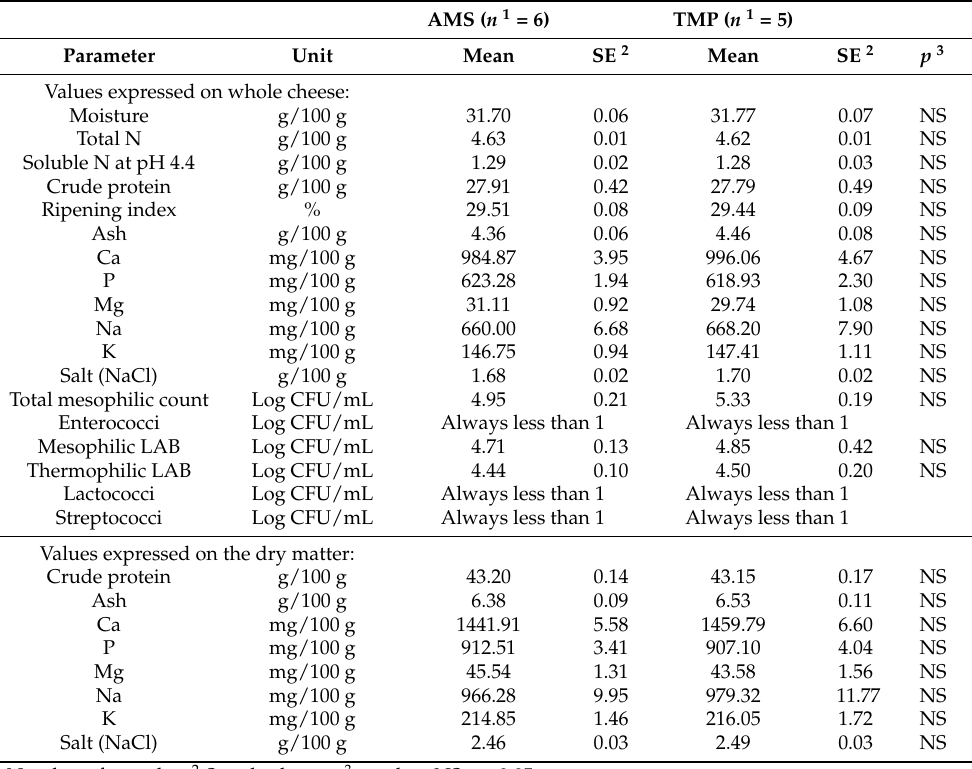
Table 5. Least square means of chemical composition parameters, mineral profile and microbial counts of the Parmigiano Reggiano ripened for 15 months obtained from herd milk milked with an automatic milking system (AMS) and with a traditional milking parlor (TMP).